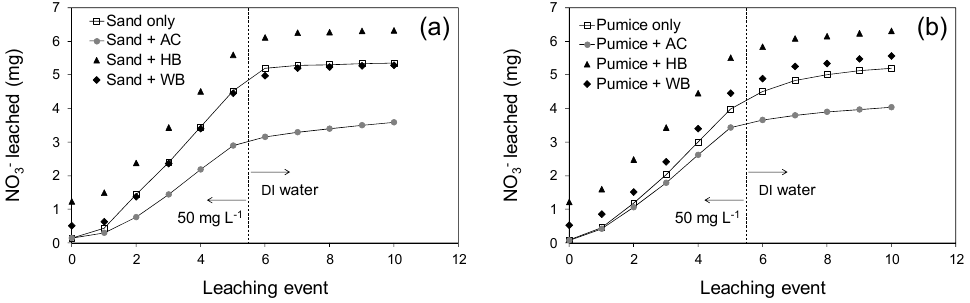
− ) leached in column effluents: ( a ) sand and ( b ) 3